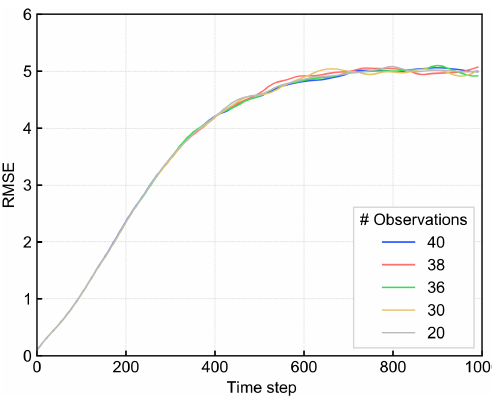
Figure 8. The same as Fig. 4, for the RC-Anl prediction.